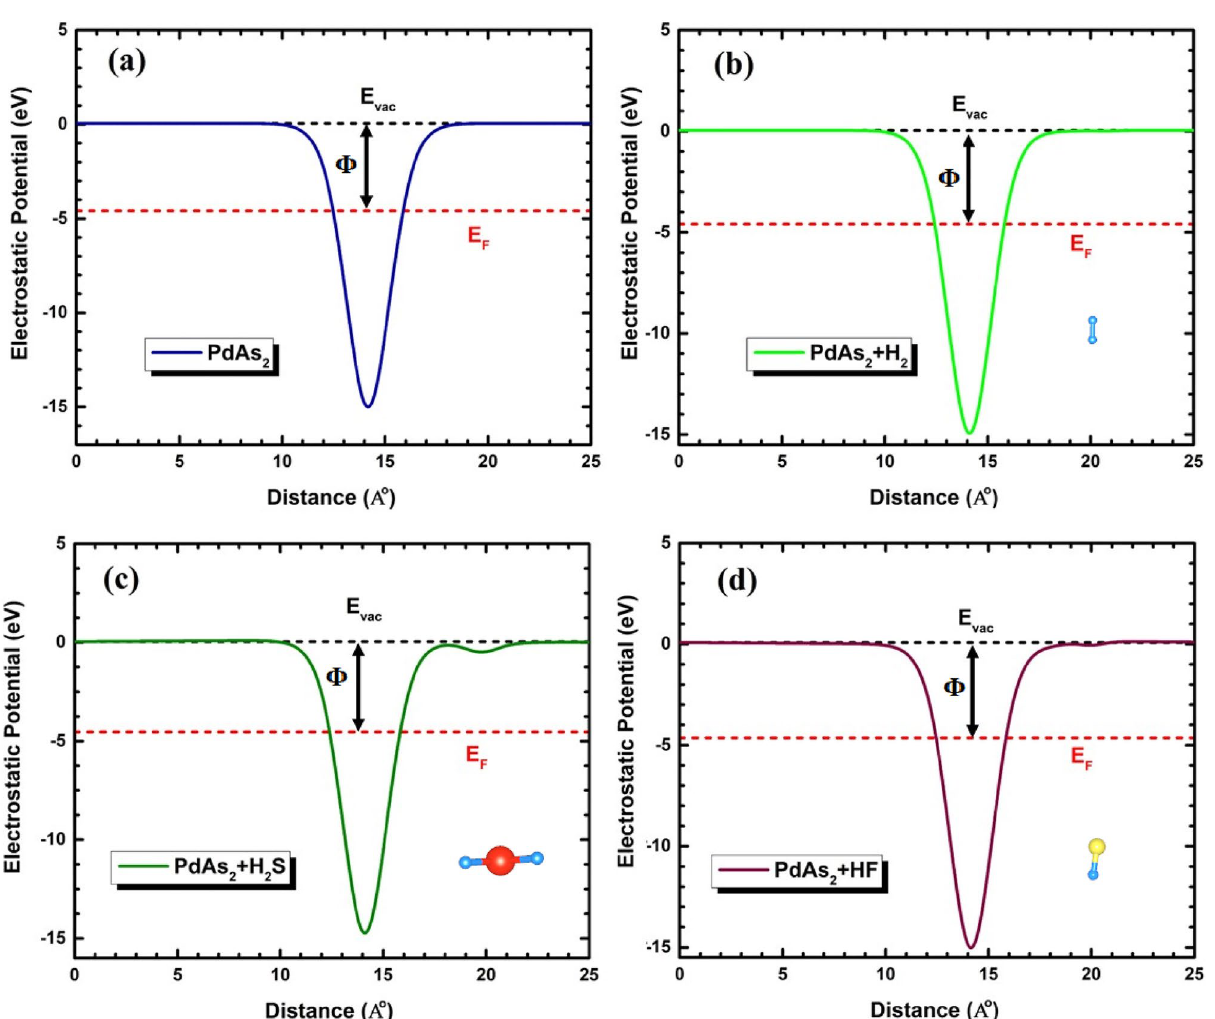
Figure 3. The planar average of the electrostatic potential of ( a ) bare monolayer and adsorbed with ( b ) H 2 , ( c ) H 2 S and ( d ) HF gas